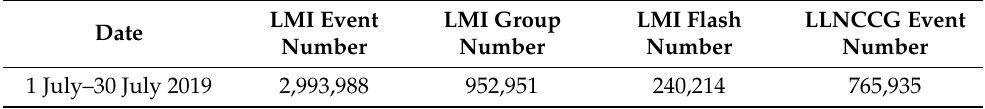
Table 2. The LMI and LLNC dataset used in this test.